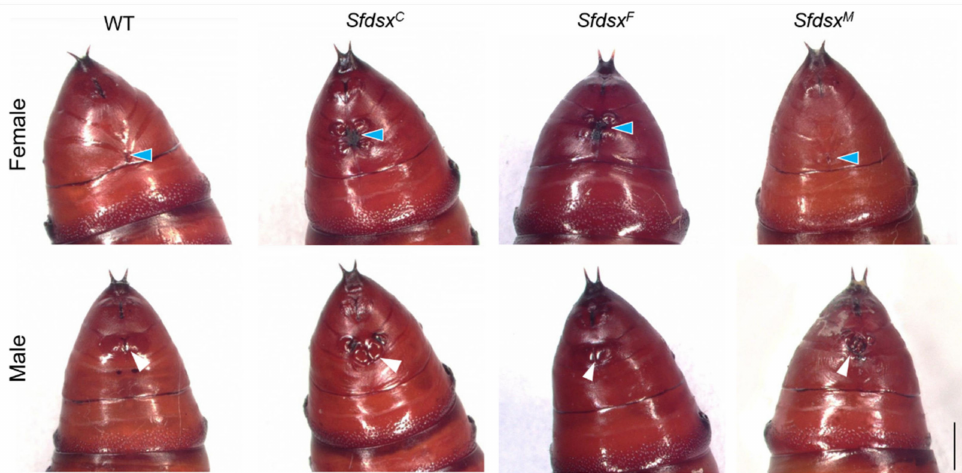
Figure 2. Malformed genital structure after Sfdsx C , Sfdsx F , and Sfdsx M mutagenesis. Photographs of typical wildtype and mutant pupae. Oviposition holes are present on female pupa on the 8th abdominal segment. A longitudinal fissure representing the gonopore is present in the middle of the 9th abdominal segment of the WT male pupa. Sfdsx C -F, Sfdsx C -M, Sfdsx F -F, and Sfdsx M -M showed abnormal morphology of the gonopore compared with that in WT. Blue arrows depict oviposition holes in females, while white arrows indicate gonopores in males. Scale bars: 1